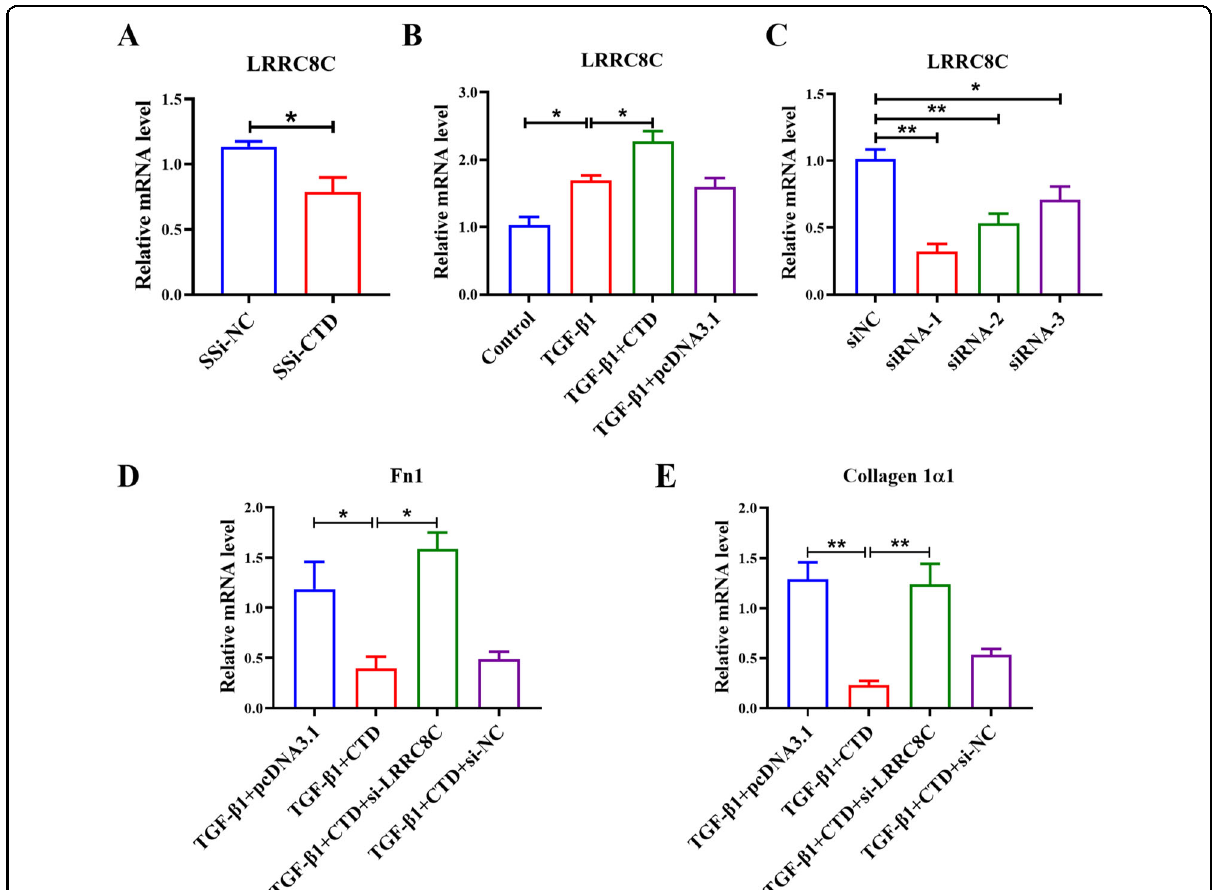
Fig. 8 LncRNA CTD-2528L19.6 regulates LRRC8C in MRC-5 cells. A , B qRT-PCR shows that silencing or forced overexpression of CTD-2528L19.6 inhibited ( A ) or promoted ( B ) the expression of LRRC8C . C-E Silencing of LRRC8C restored the expression levels of Fn1 and Collagen 1 α 1 in TGF- β 1- treated MRC-5 cells. n = 4; * P < 0.05, ** P <